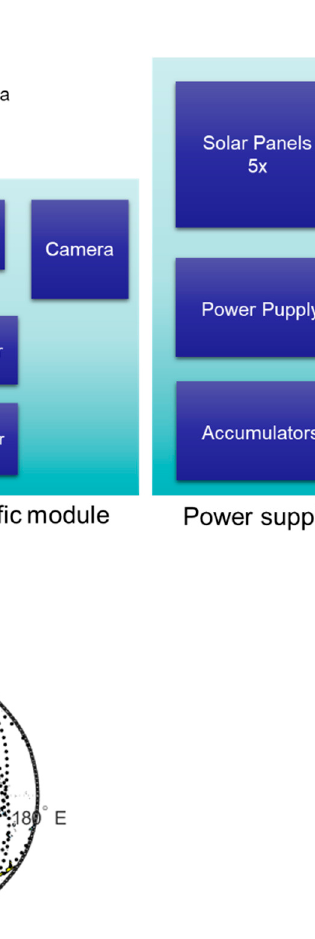
Figure 1. Lucky 7 CubeSat.